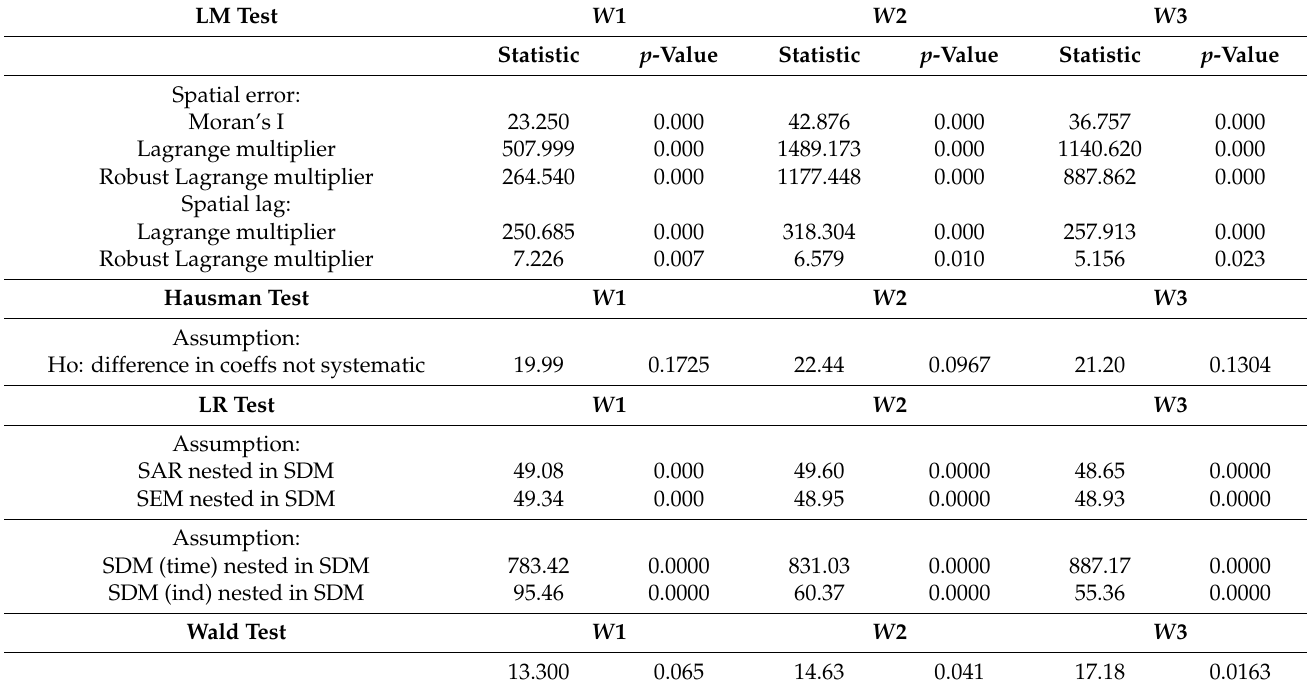
Table 6. Correlation test results under each spatial weight